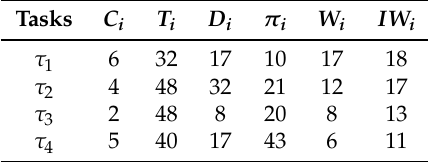
Table 1. Tasks’ attributes.